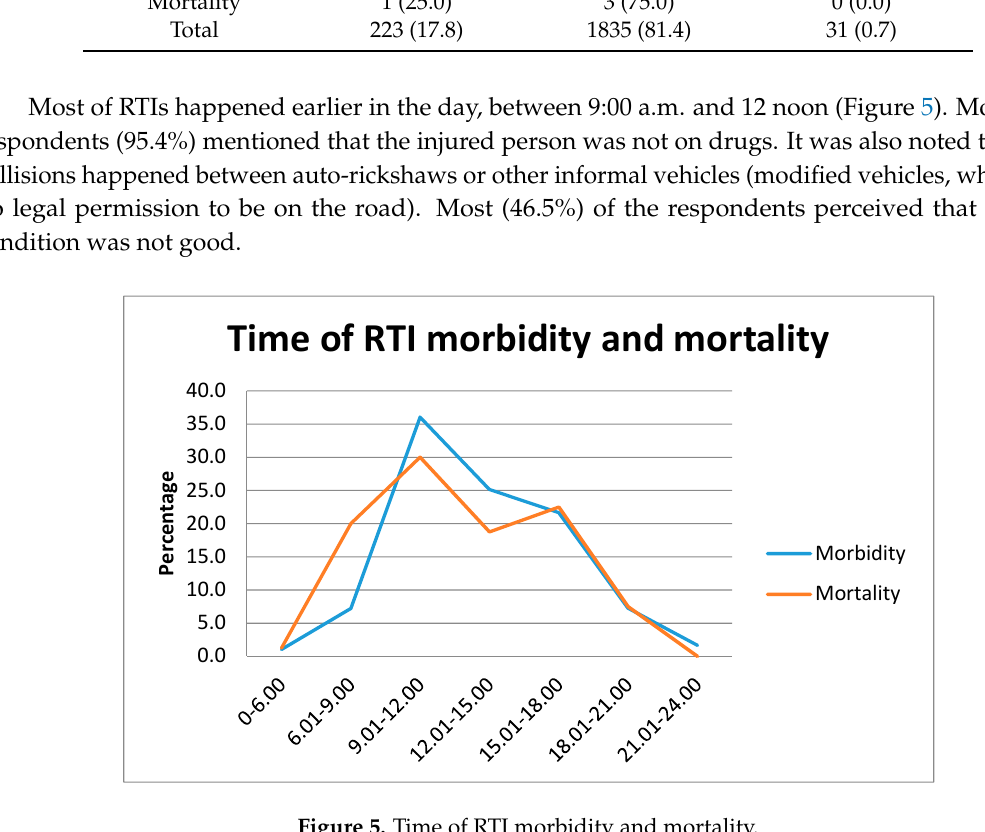
Table 3. Use of safety device at the time of RTI among motorcyclists.